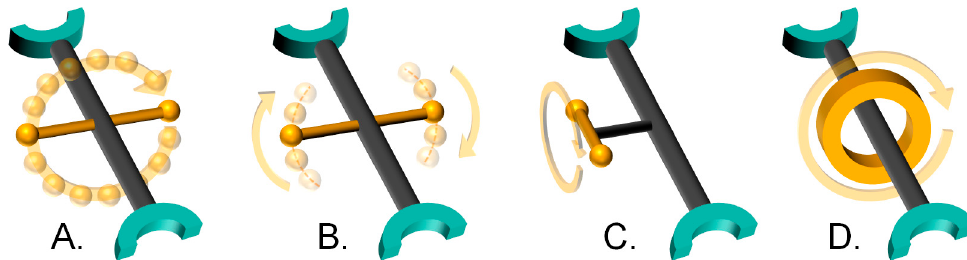
Figure 1. Illustration of the four types of rotational linker dynamics: ( A ). Complete rotation, ( B ). Partial rotation, ( C ). Side group rotation, ( D ). Mechanically interlocked molecule rotation. Complete rotation often occurs in steps comprising a fraction of the 360° path, which are often referred to as jumps, hops or flips. The nature of these jumps is determined by the torsional potential of the rotor [13]. Figure 2 illustrates the torsional potential of a terephthalate rotor. It can be seen that minima in the potential energy are found every 180° of relative rotation between the para -phenylene rotator and the coordinated carboxylate stators. These minima determine the starting and ending position of the jumps, which must surpass an energetic barrier, E b .